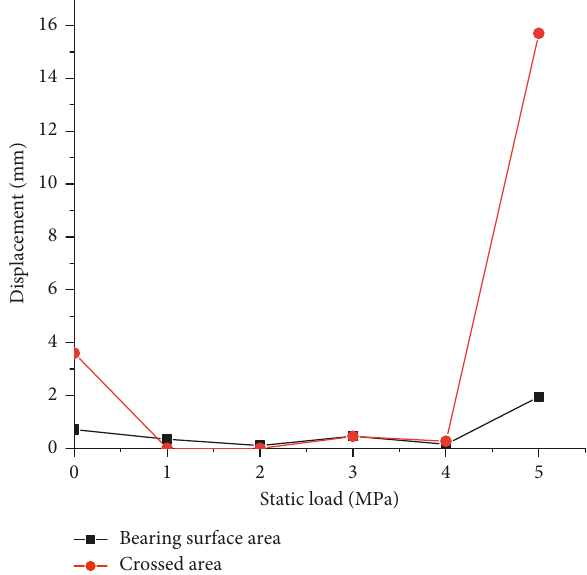
Figure 9: Displacement of impact surface under different